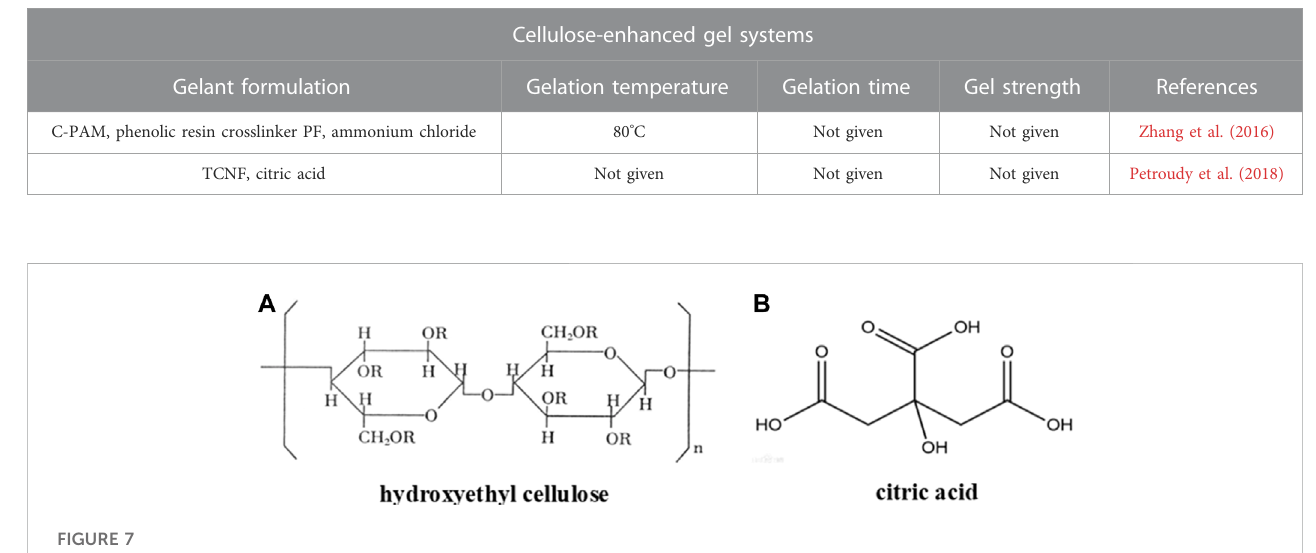
TABLE 2 Progress of cellulose-enhanced gel systems.